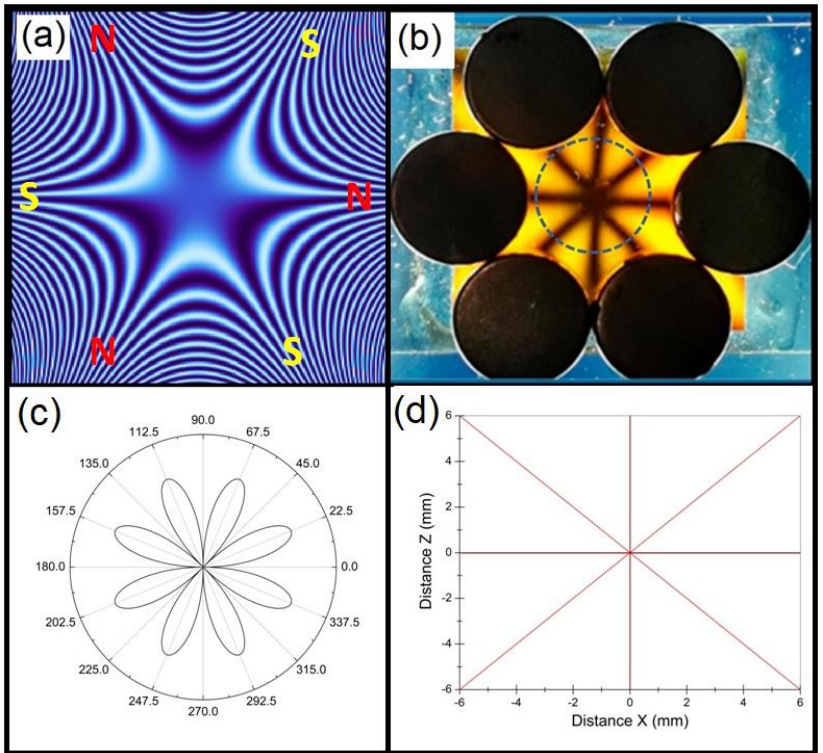
Figure 9. ( a ) Line intensity diagram of a sextupolar magnetic field. ( b ) Six magnetic disks forming a sextupolar field in the ferrofluid sample for a pair of crossed linear polarizers. ( c ) Polar graph of the intensity of the Stokes vector S for the Mueller matrix, simulating a grating of a sextupolar magnetic field, which is equivalent to what was observed for the light intensity in the experiment, as marked with the circle with the green dashed line in ( b ). In ( d ), there is the graph of the isogyres lines of a sextupole, which usesEquations (2) and (3) to explain the isogyres for a dipole for y = 0.0 mm.